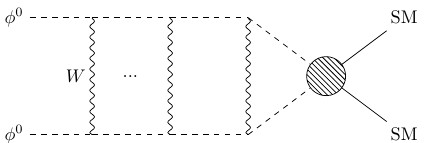
Figure 5: Ladder diagram illustrating the non-perturbative effect of a long-range potential leading to a Sommerfeld-like